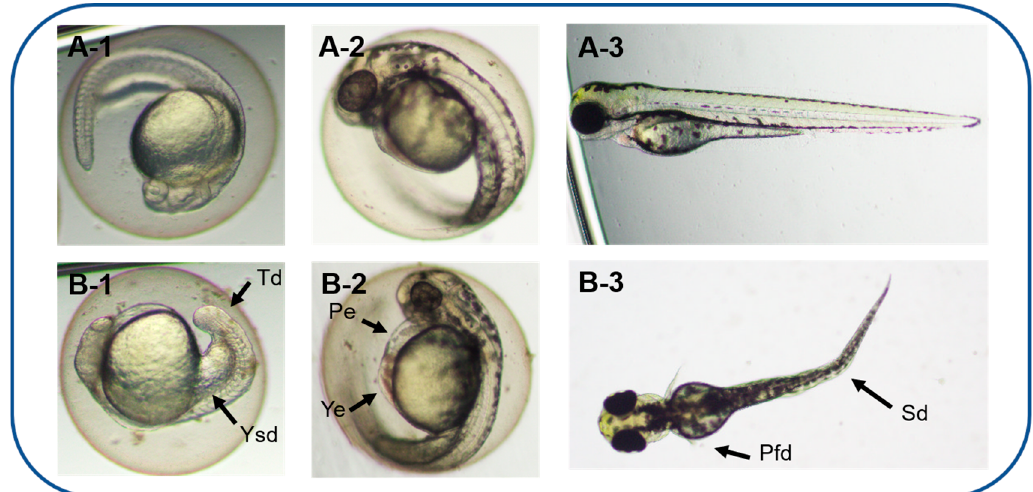
Figure 4. Morphological abnormalities induced by AMs from A. carterae at different times. The normal zebrafish embryos in the control group were at 24 hpf ( A-1 ), 48 hpf ( A-2 ), and 72 hpf ( A-3 ). Typical malformations caused by 2.03 µ g/mL of AMs on zebrafish embryonic development at 24 hpf ( B-1 ), 48 hpf ( B-2 ), and 72 hpf ( B-3 ). Abbreviations: Pe, pericardial edema; Pfd, pectoral fin deformities; Sd, spinal deformation; Td, tail extension deformity; Ye, yolk edema; Ysd, yolk sac deformity.